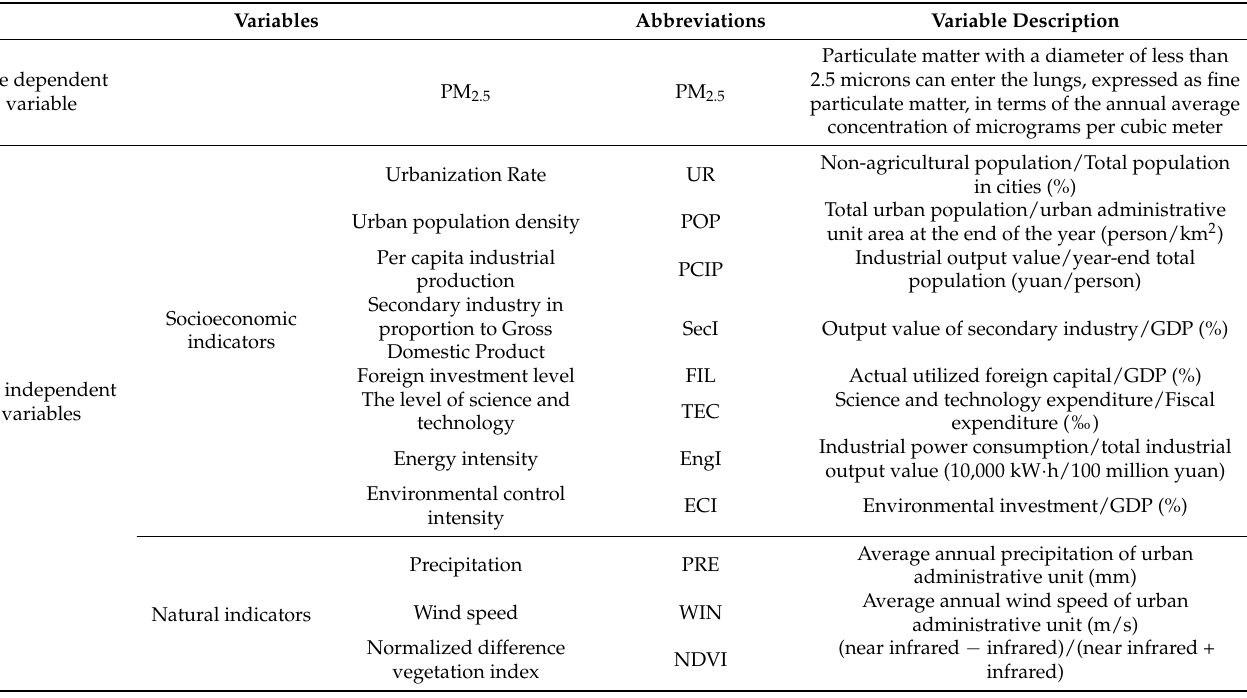
Figure 1. The study area. The red dots represent 275 major prefecture-level cities. Table 1. Description of variables.